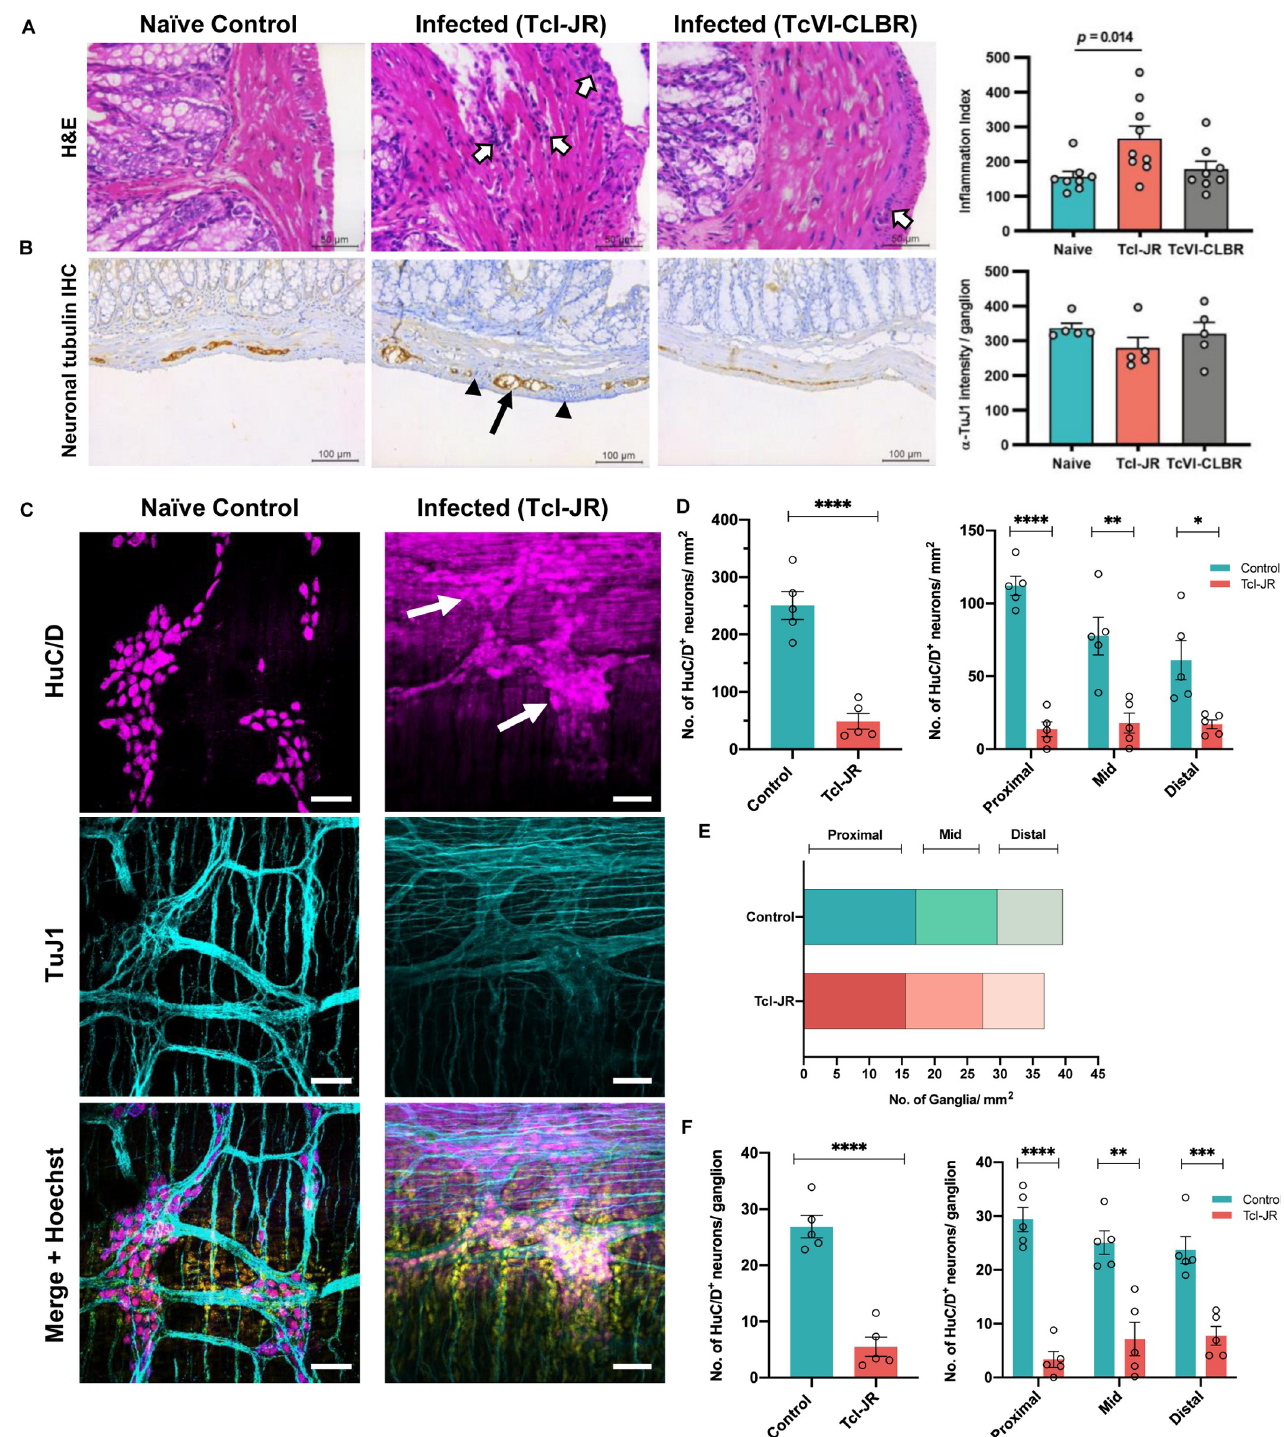
Fig 5. Effects of chronic T . cruzi infection on the enteric nervous system. A. Representative brightfield images of 5 μ m thick colon sections stained with haematoxylin-eosin. Samples were cut as transverse cross-sections and images are oriented to show the mucosa to the left of the smooth muscle layers and serosa at the right edge. Inflammatory infiltrates are apparent in infected samples, visible as increased numbers of haematoxylin (purple) stained nuclei (white arrows). Images were taken at 400X magnification, scale bar = 50 μ m. Adjacent bar plot shows number of nuclei per field to quantify cellular infiltration in TcI-JR ( n = 8), TcVI-CLBR ( n = 10) infected mice compared to na ï ve controls ( n = 8). B. Representative brightfield images of 5 μ m thick colon sections to detect neuropathology during T . cruzi infection detected by immunohistochemistry. Samples were cut as transverse cross-sections and images are oriented to